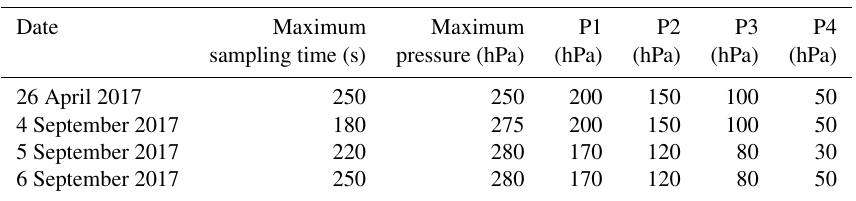
Table 4. Preset sampling parameters. Sampling is completed after either the maximum pressure in the manifold or the maximum sampling time is reached. P1–P4 are the preset targeted pressure